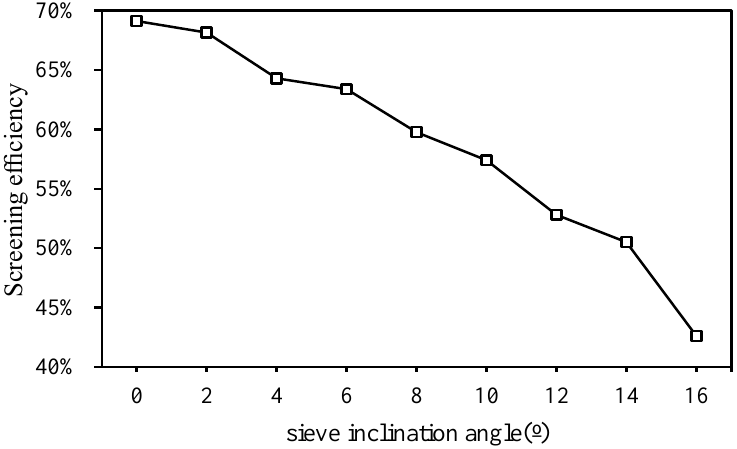
Figure 8. Screening efficiencies of a cantilevered vibrating sieve (CVS) for different sieve inclination angle.